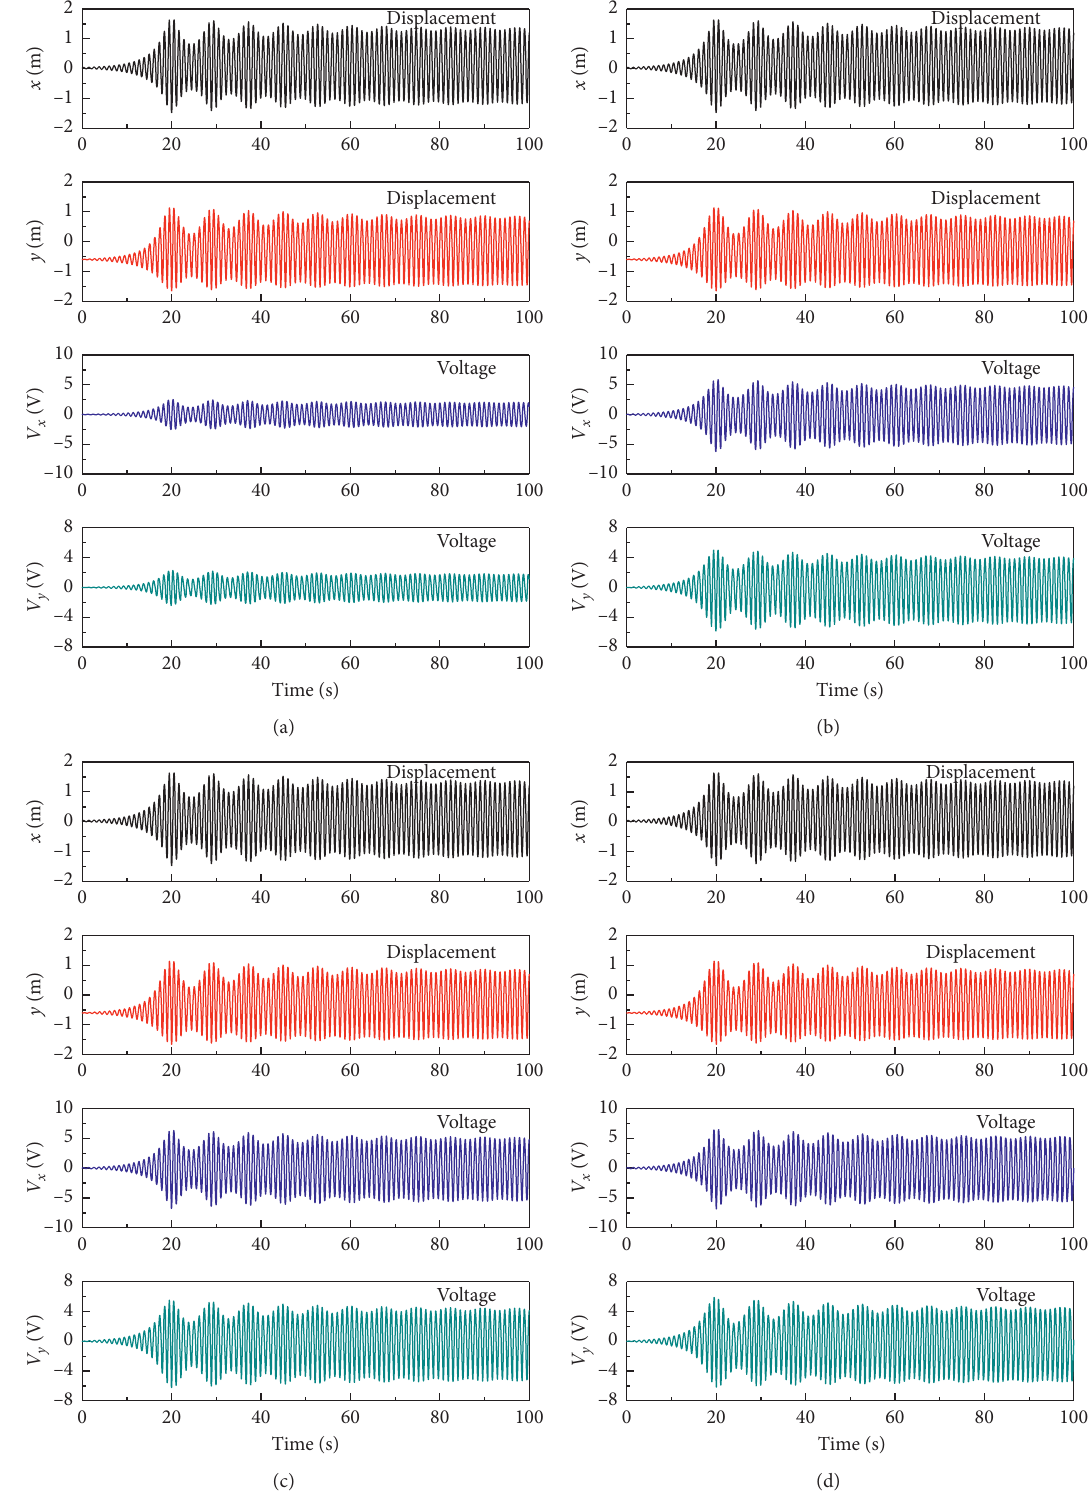
Figure 25: Ignoring separation, the displacement and output voltage of the friction system when the external electrical resistance